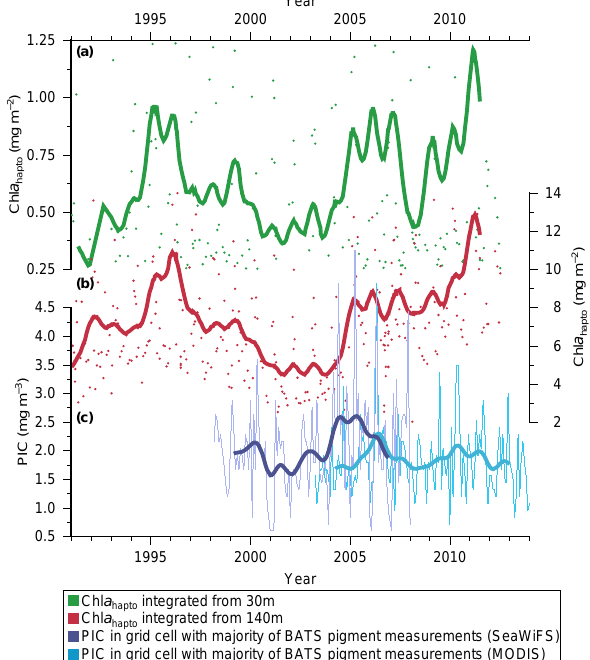
Figure 6. Chl a total measured at BATS and satellite-derived Chl a . Chl a total integrated from 30m is shown in (a) , while Chl a total integrated from 140m depth is shown in (b) . Chl a data shown in (c) were obtained from the 5min satellite grid cell with the most BATS measurements (see Fig. 1). Bolder lines represent a 2-year Gaussian filter on the data. We restricted the y axes in panels (a) and (b) to highlight the filtered data; see Fig. S4 to view all unfiltered data